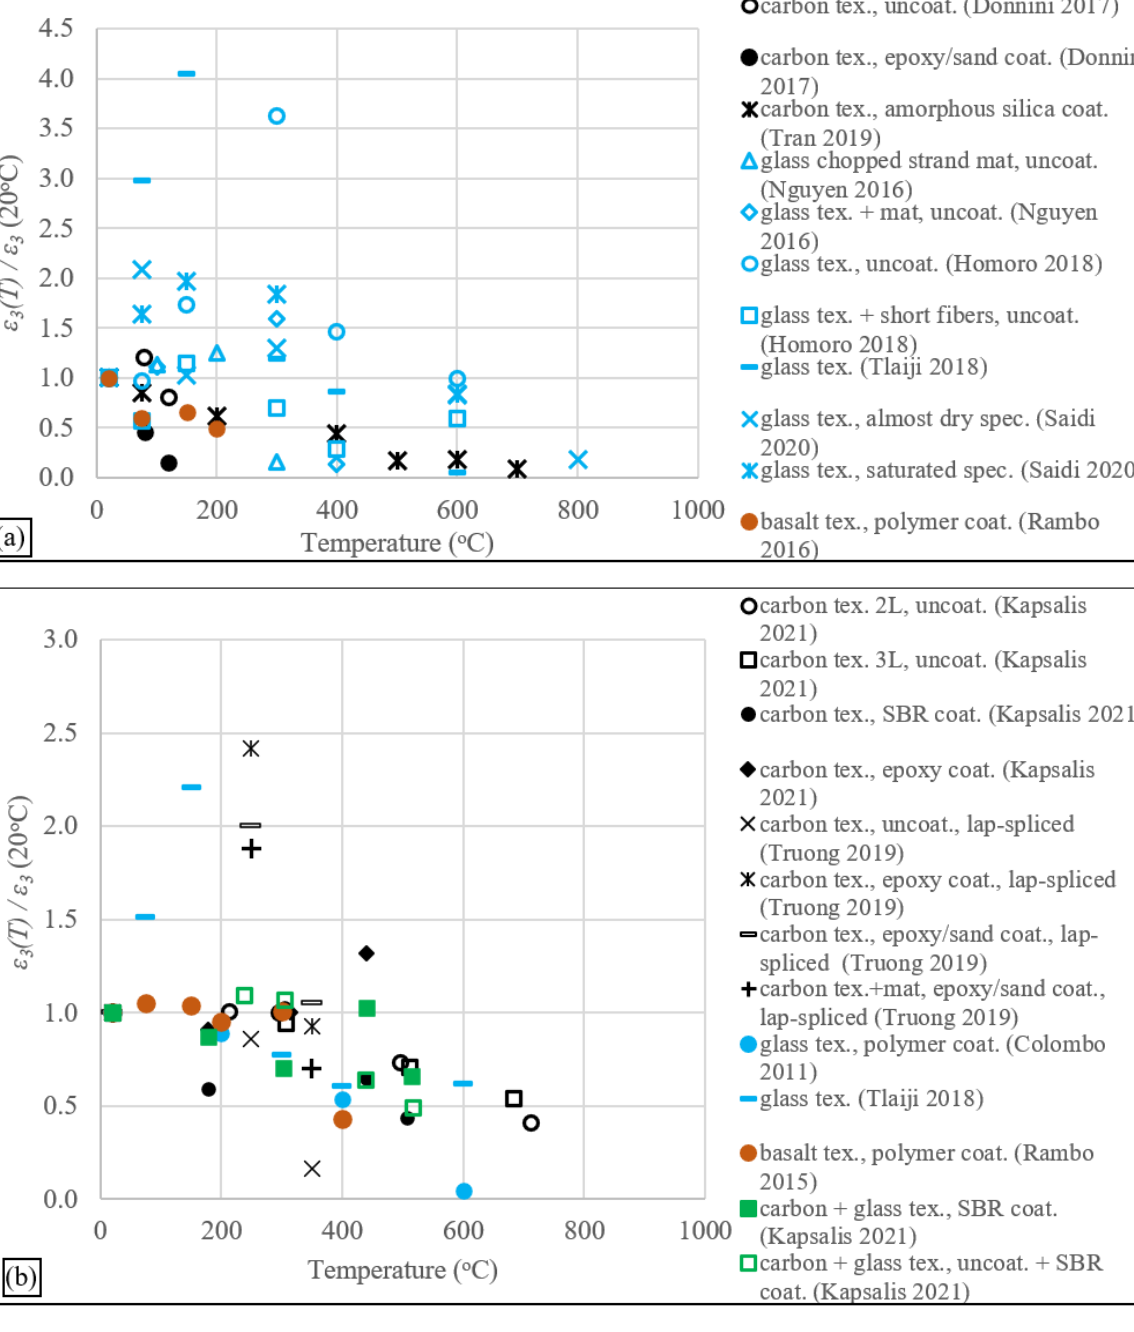
Figure 7. Strain at maximum stress ( ε 3 ) versus exposure temperature for various TRC compositions; ( a ) specimens loaded while in heated conditions; ( b ) specimens tested after cooling down.